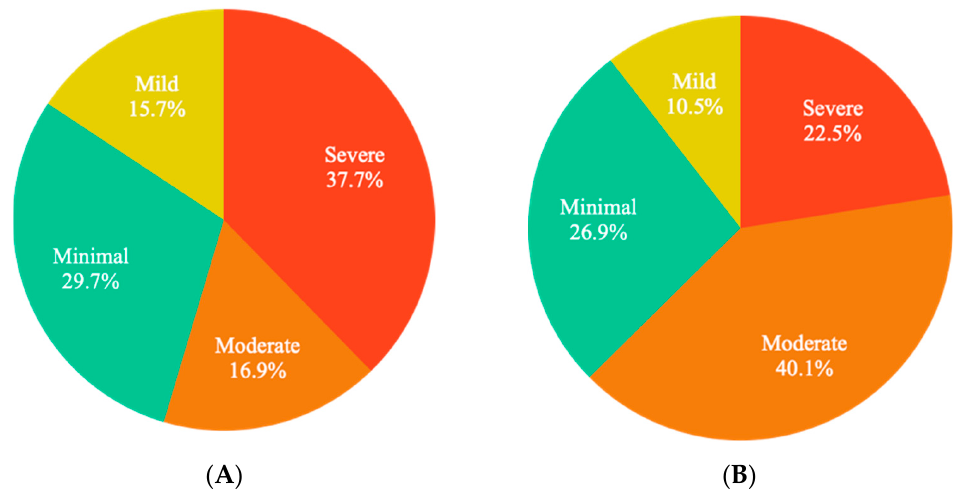
Figure 2. General frequency of anxiety and depression obtained during the study and its classification by severity. Figure 2 shows the results of primary screening using Mentali: ( A ) for depression ( n = 83); ( B ) for anxiety ( n = 93). During the period evaluated, the presence of symptoms of moderate–severe anxiety and depression were present in 62.6% and 54.6% of the studied population.